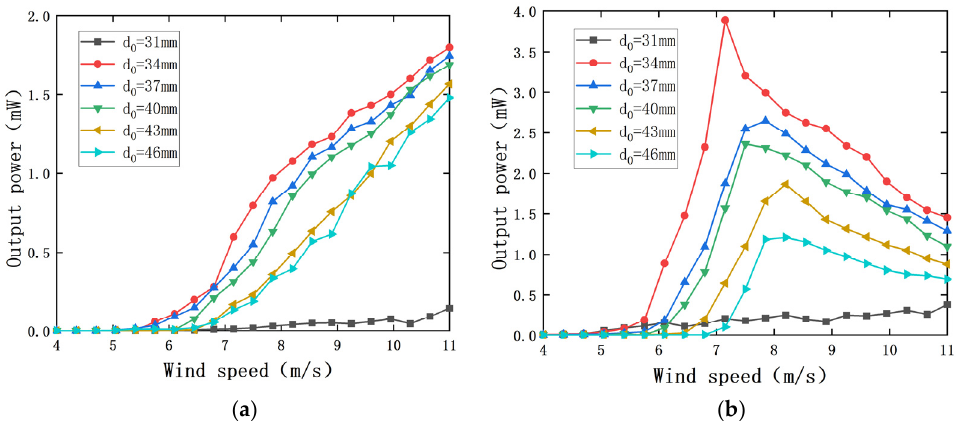
Figure 8. Change curve of output power with wind speed under different d 0 : ( a ) output power of the PEH; ( b ) output power of the EEH.